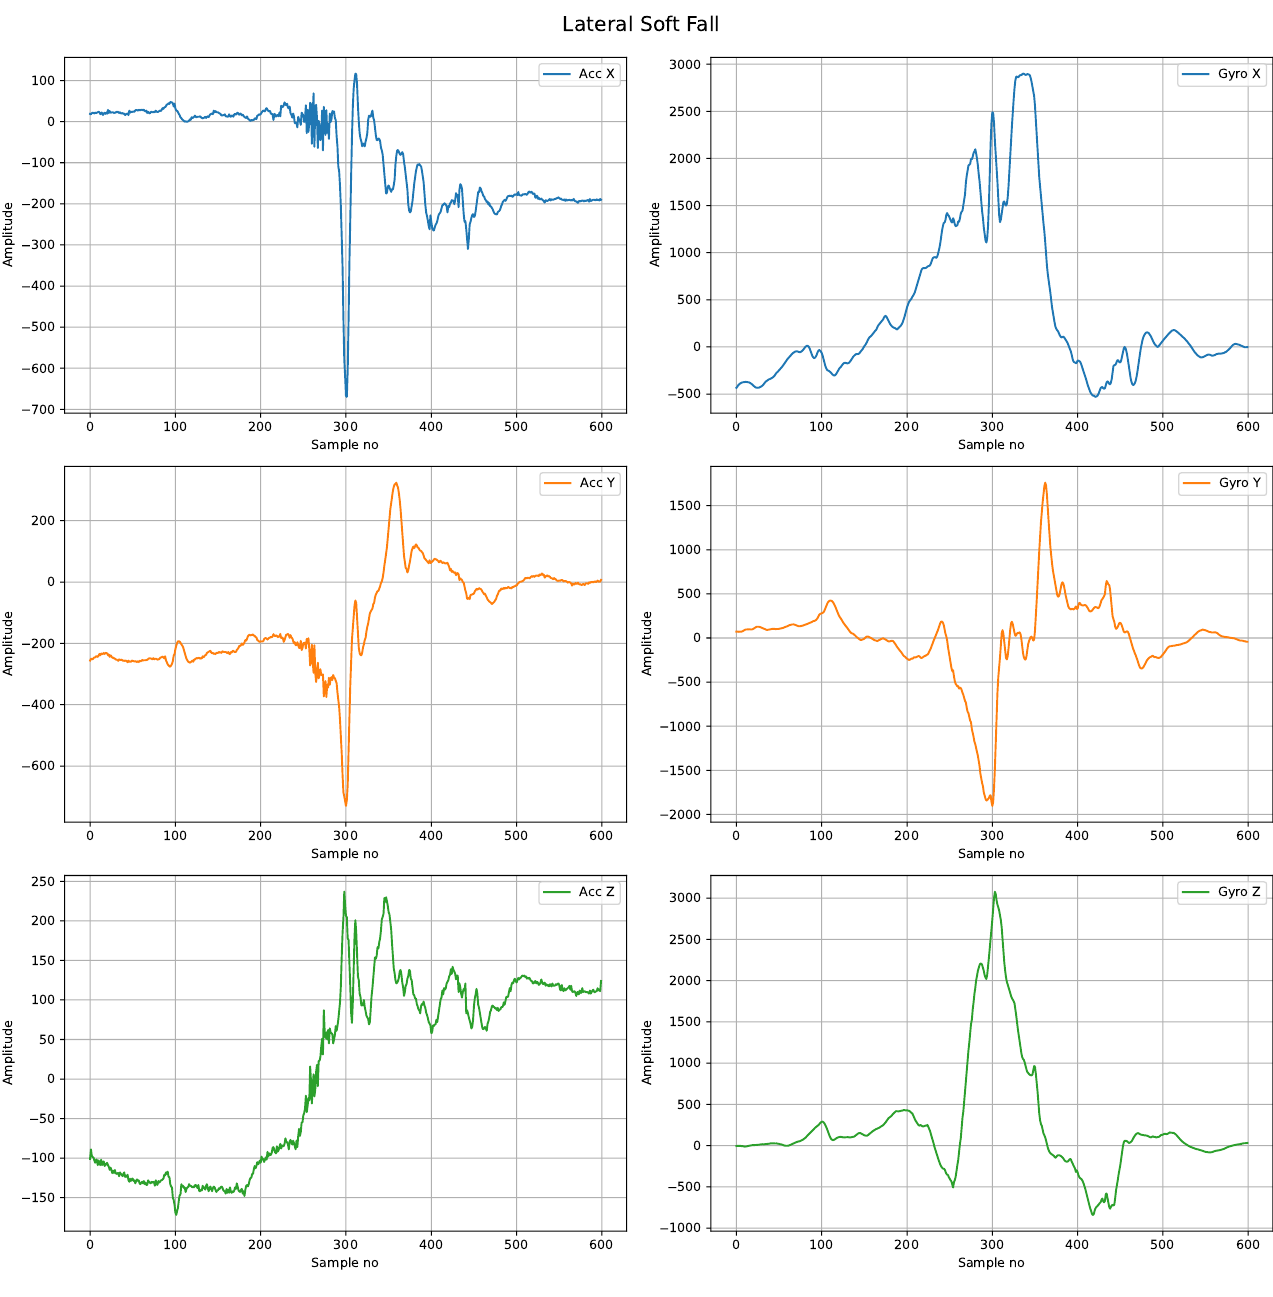
Figure A6. Accelerometer and gyroscope measurements: lateral soft